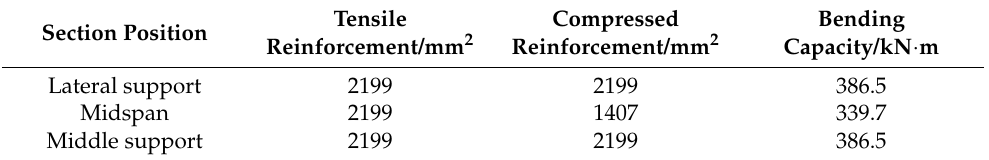
Table 3. Bending capacity of the large-span top